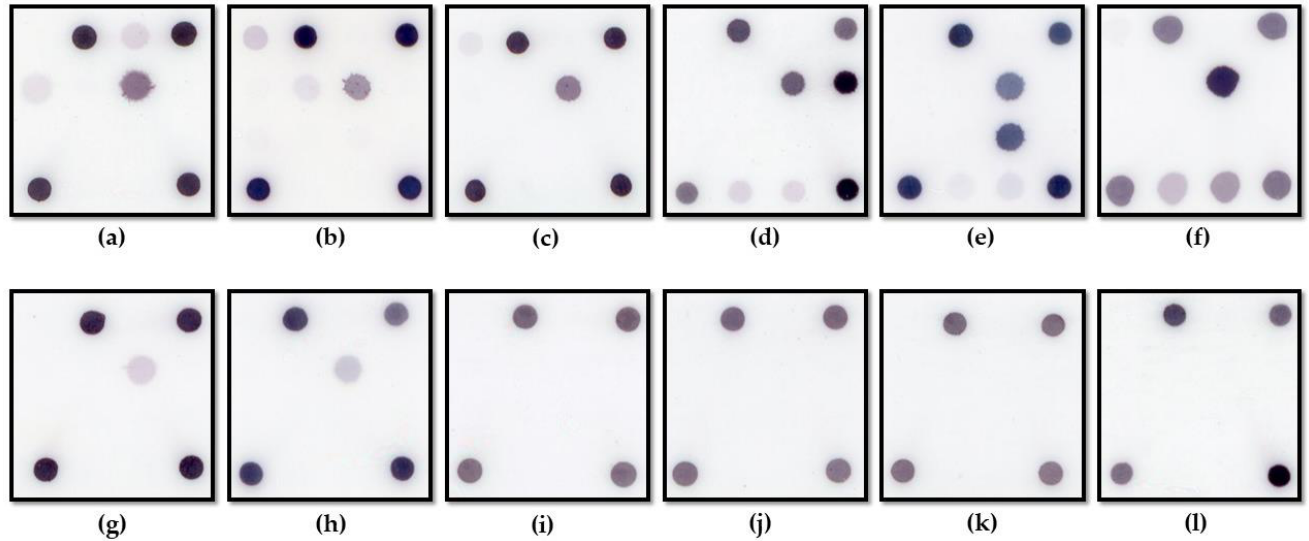
Figure 2. Representative results of the dot hybridization array for detecting fungal keratitis. ( a – c ) Fusarium keratitis patients with respective pathogens of F. solani , F. verticillioides , F. delphinoides ; ( d – f ) Aspergillus keratitis patients with respective pathogens of A. flavus , A. fumigatus , and A. niger ; ( g , h ) Fungal keratitis patients with respective pathogens of Curvularia geniculata and Candida tropicalis ; ( i ) Pseudomonas aeruginosa keratitis; ( j ) herpes simplex keratitis; ( k ) Acanthamoeba palestinensis keratitis; ( l ) microsporidal ( Vittaforma corneae ) keratitis. Table 3. Demographic data of subjects. Clinical Parameters